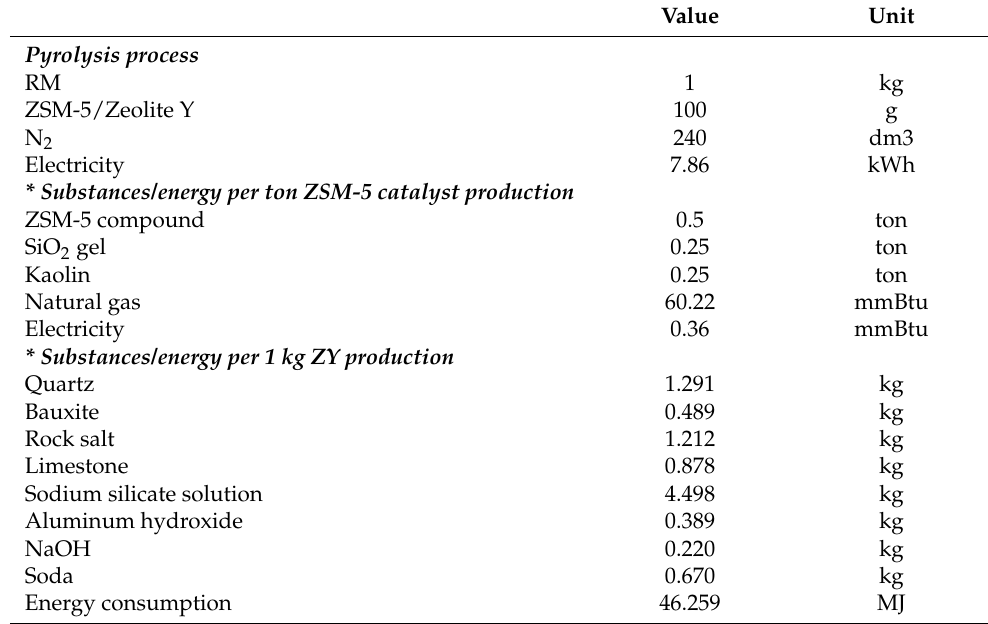
Table 4. Material and energy flows involved in catalyzed pyrolysis